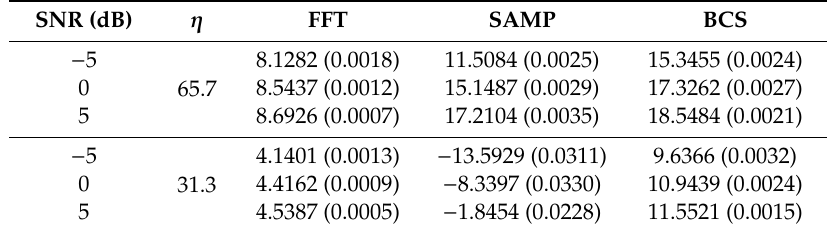
Figure 6. The SCR versus di ff erent jammer ratio of the echo signal. Table 2. Reconstructed signal-to-clutter ratio (SCR) performance with di ff erent SNR and ratio (dB) 1